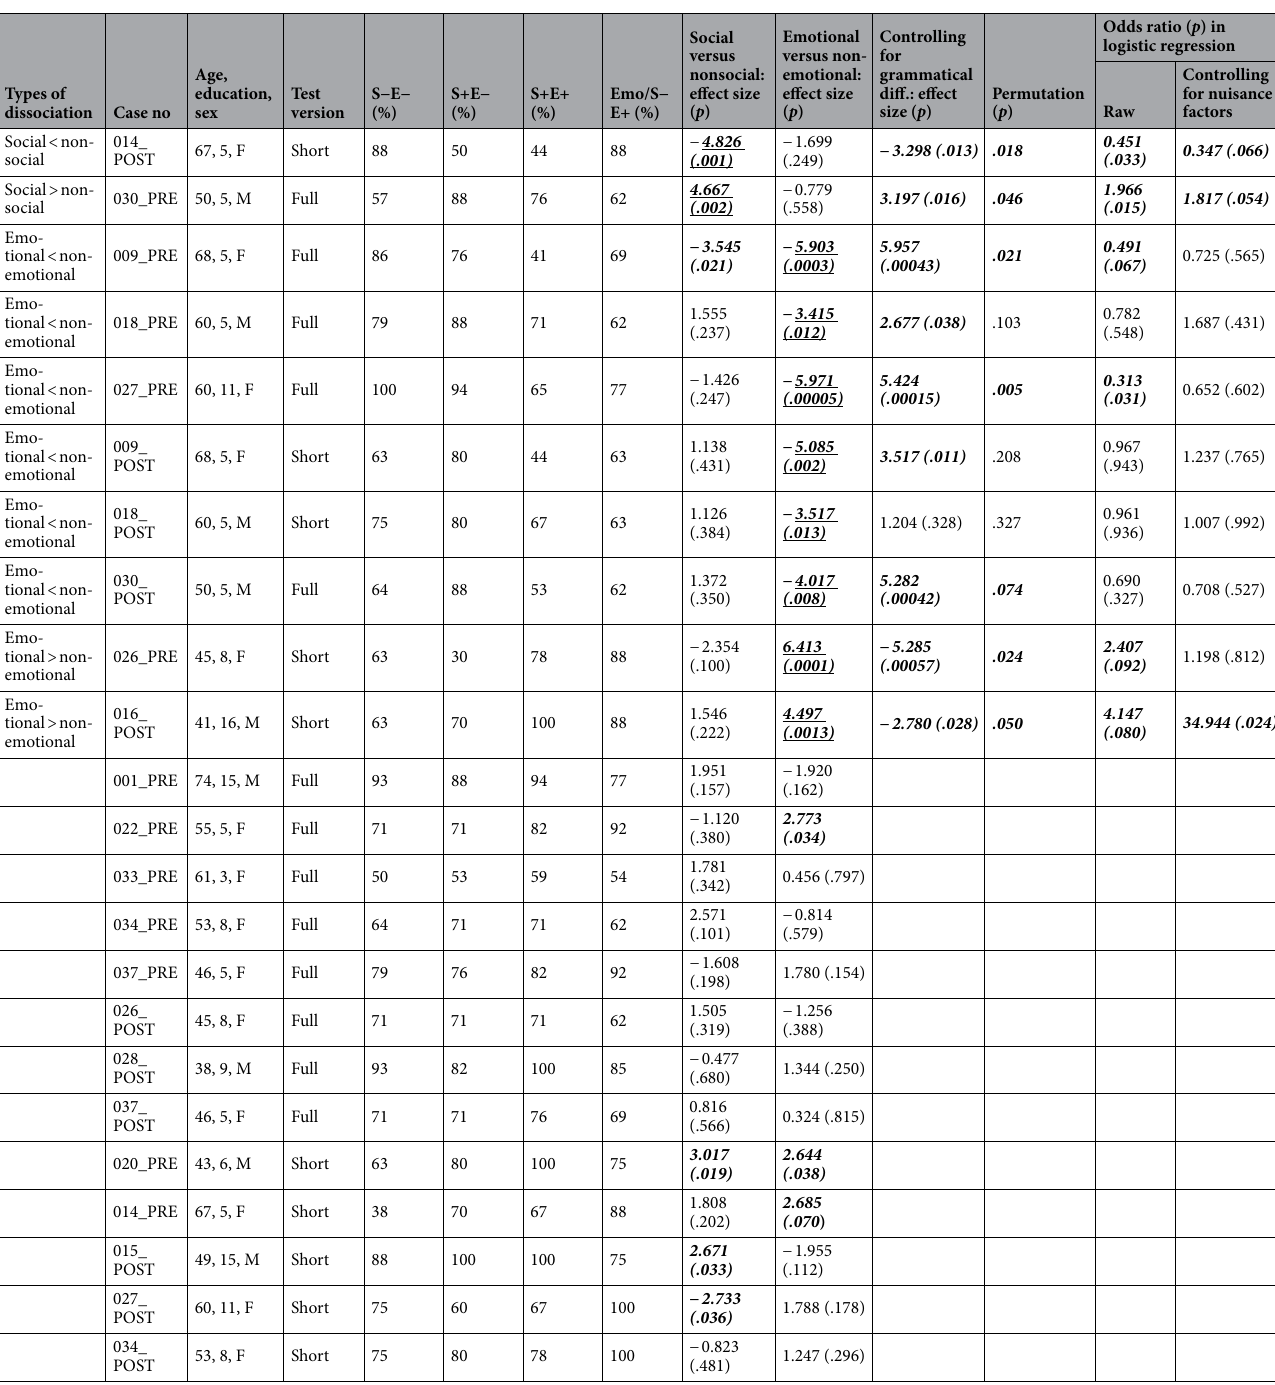
Table 1. Behavioral performances (proportion correct) of each category in 23 cases with deficits in non-object semantic judgment and validation results for 10 cases with FDR-corrected significant dissociations. Numbers in bold and italic fonts indicate marginally significant results ( p < .1). Numbers in bold, italic, and underlined fonts indicate dissociations significant at FDR q < .05 across the 23 cases. S−E− nonsocial non-emotional words, S+E− social non-emotional words, S+E+ social emotional words, Emo/S−E + , emotional state words with relatively low social ratings, PRE examined before surgery, POST examined shortly after surgery, Full the full-version test, Short the short-version test, F female, M